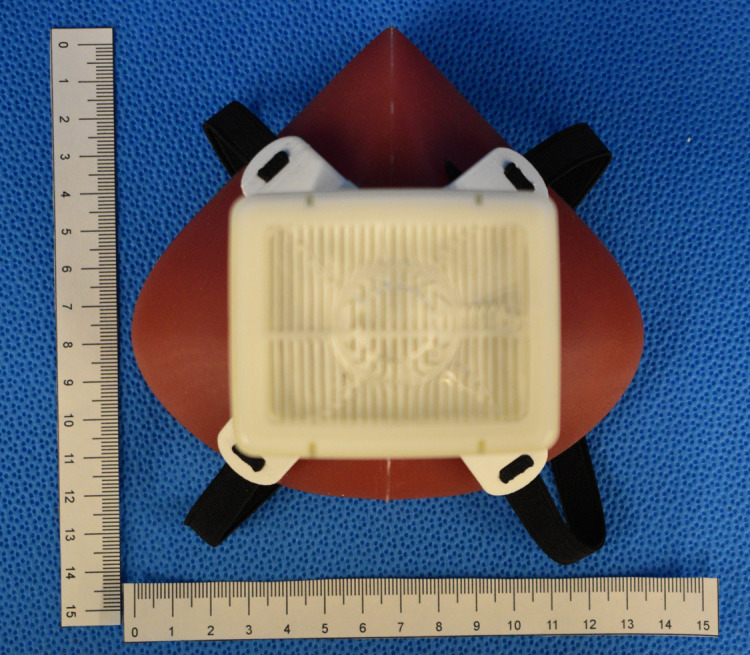
Silicone mask body with harness and Intersurgical Air-Guard™ pictured.